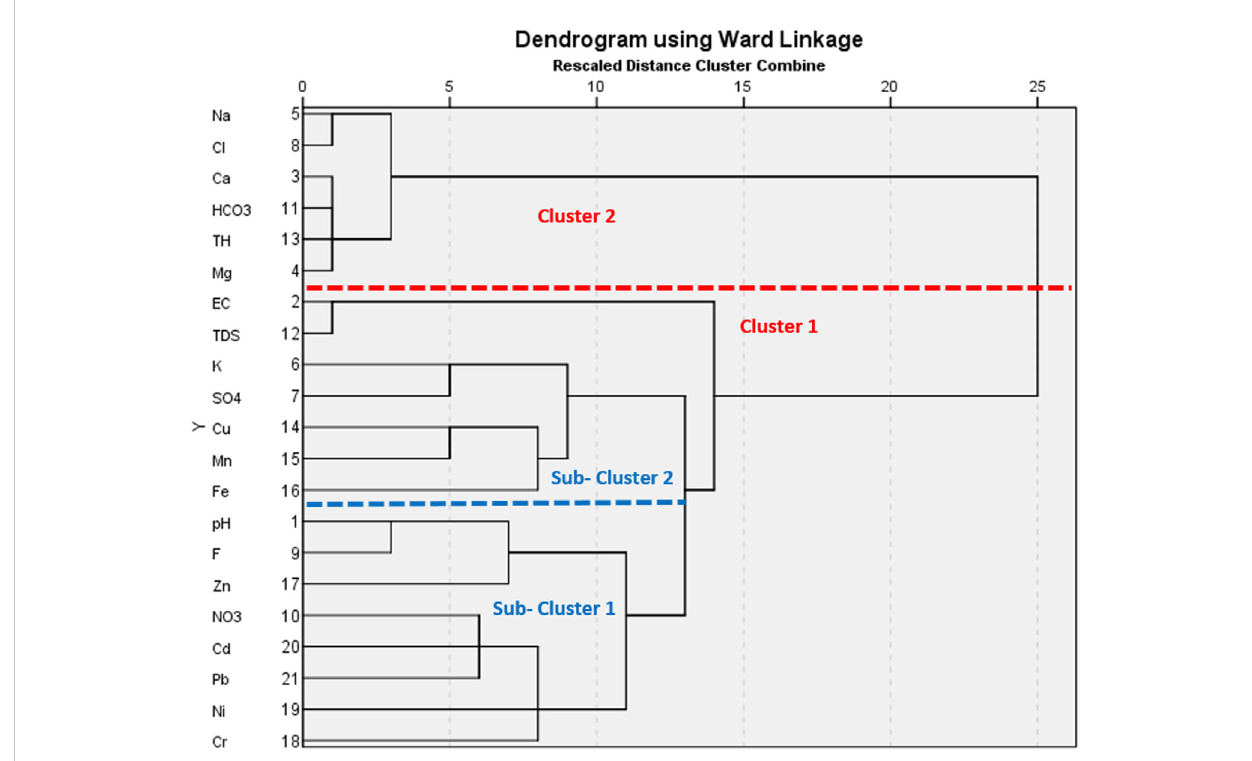
FIGURE 7 A dendrogram representing the cluster groupings of the groundwater samples based on WQI and